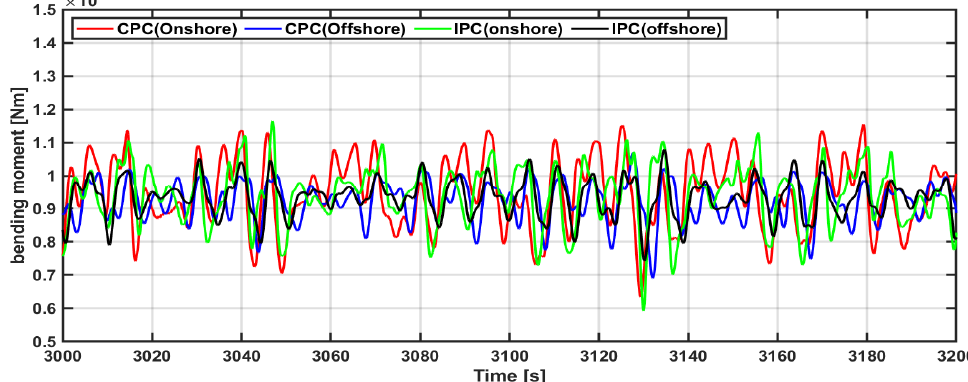
Figure 11. Blade bending moment of floating offshore wind turbine based on pitch controller.